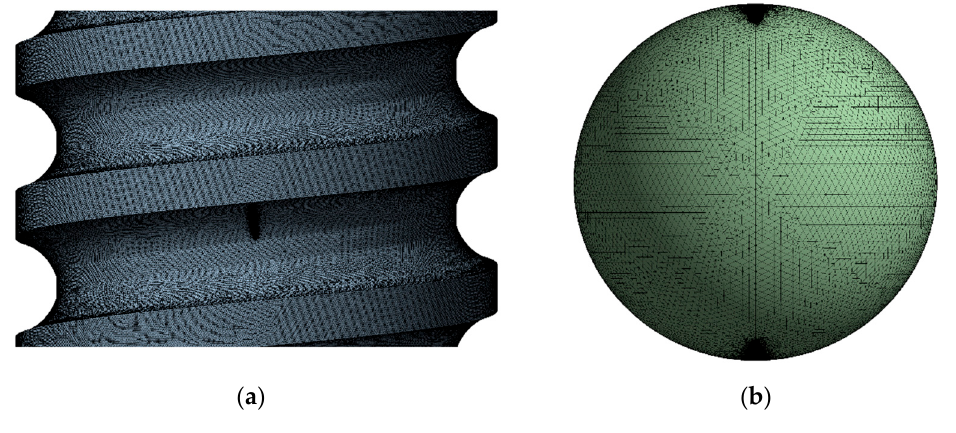
Figure 10. Mesh configuration: ( a ) Shaft; ( b ) Ball. Table 5. Results of mesh dependency test.